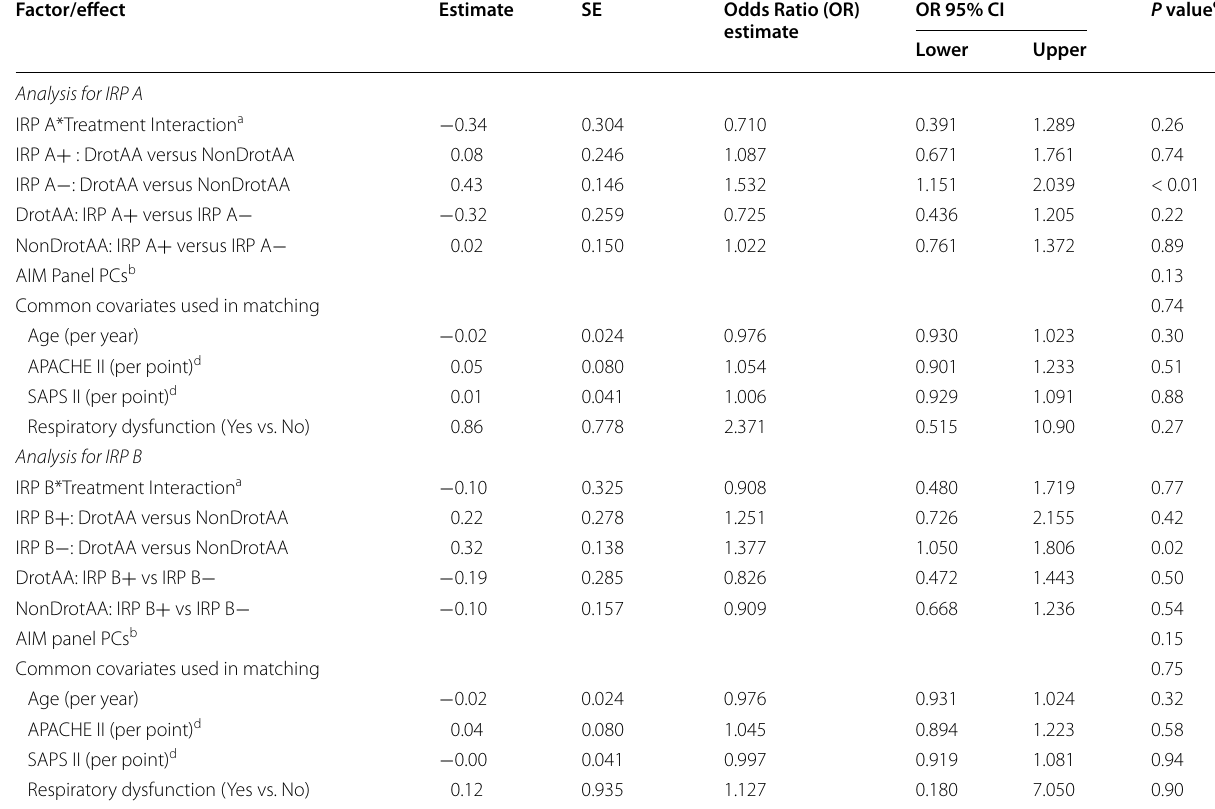
Table 3 Secondary analysis with common matching variables included as covariates—conditional logistic regression for differential treatment effects of IRP A and IRP B on